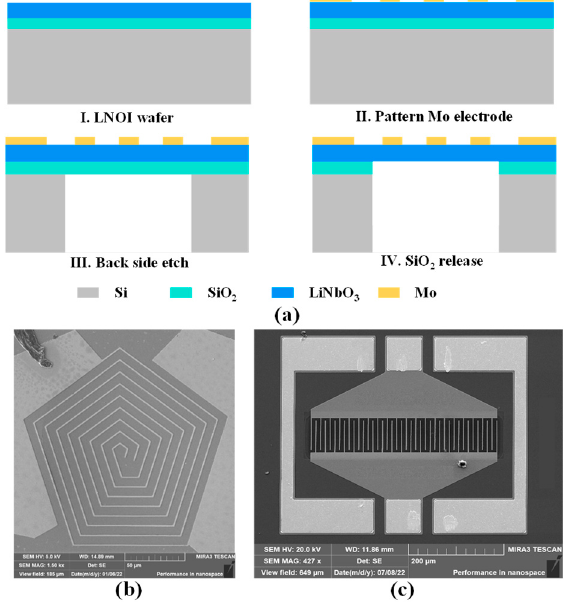
Figure 6. ( a ) Fabrication process flow for our resonator. Ⅰ . Cross-section view of the LNOI wafer. Ⅱ . Mo electrode pattern on the surface of LiNbO 3 . Ⅲ . Backside Si deep reactive-ion etch. Ⅳ . Wet etch of buried SiO 2 layer. ( b ) SEM image of the fabricated device with pentagon spiral electrodes. ( c ) SEM image of the fabricated device with IDEs.